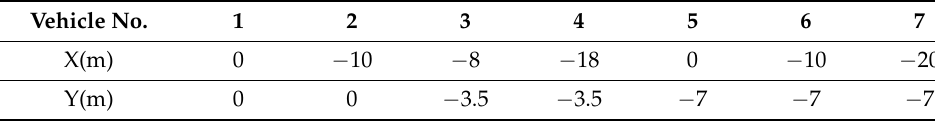
Figure 4. The initial scene of the multi-lane simulation. Table 2. Vehicle starting positions in the multilane simulation.